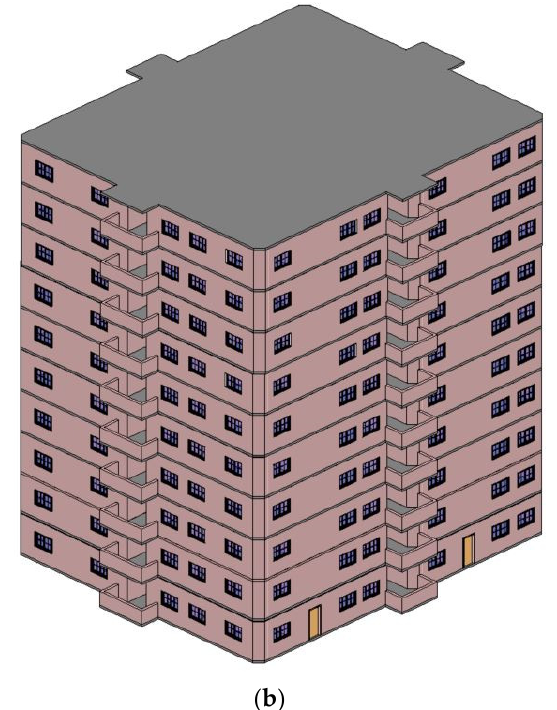
Figure 2. Floor plan and 3D BIM model of the case study building. ( a ) Floor plan, ( b ) floor plan.